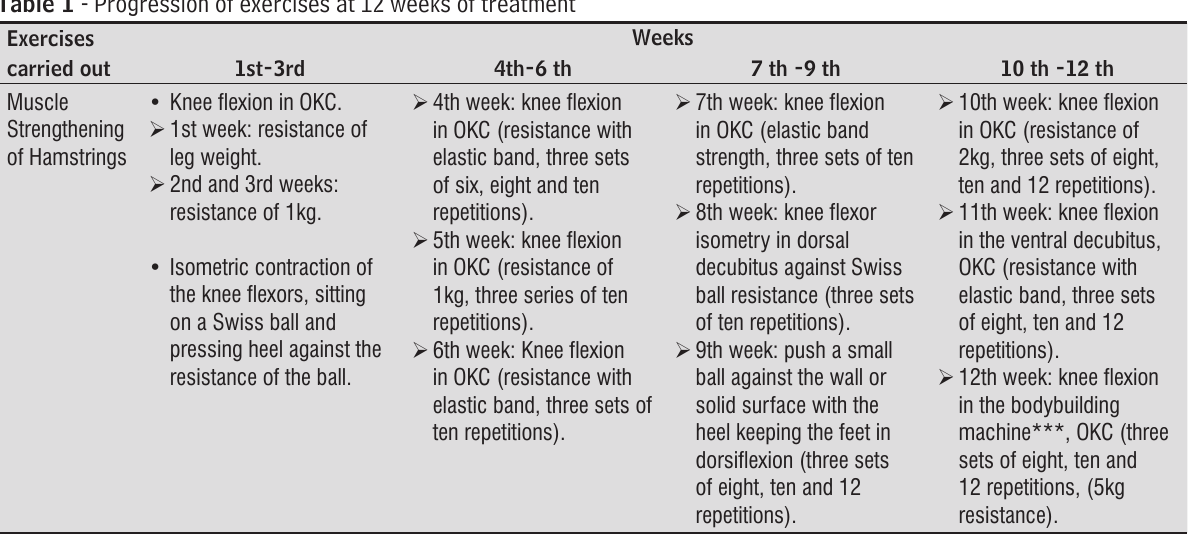
Table 1 - Progression of exercises at 12 weeks of treatment